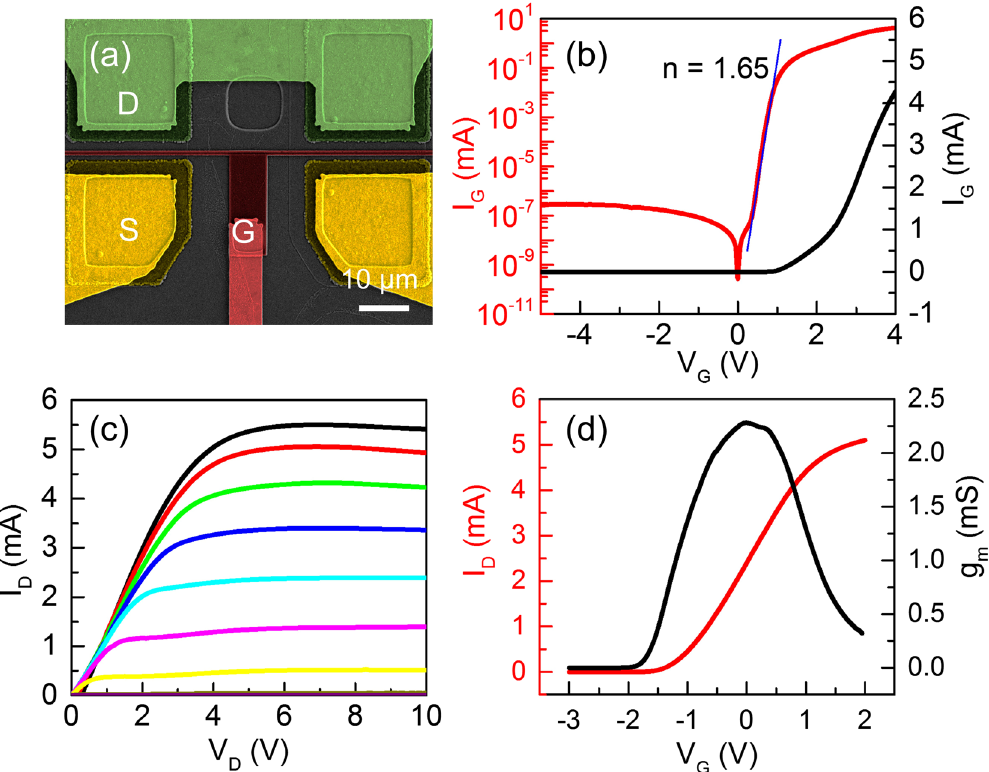
Figure 5. NM HEMT on SiO 2 /Si. ( a ) The SEM image of a device with two separate 25 µ m × 4 µ m channels. Electrodes are colored and labeled. I-V is measured with one channel. ( b ) I G -V G of the Schottky gate in linear (black) and logarithmic (red) scales. ( c ) I D -V D at different gate bias from − 3 V to 2 V, with step of 0.5 V. ( d ) Transfer characteristics (I D -V G ) with V D of 4 V (red curve). Measured transconductance g m is also shown in